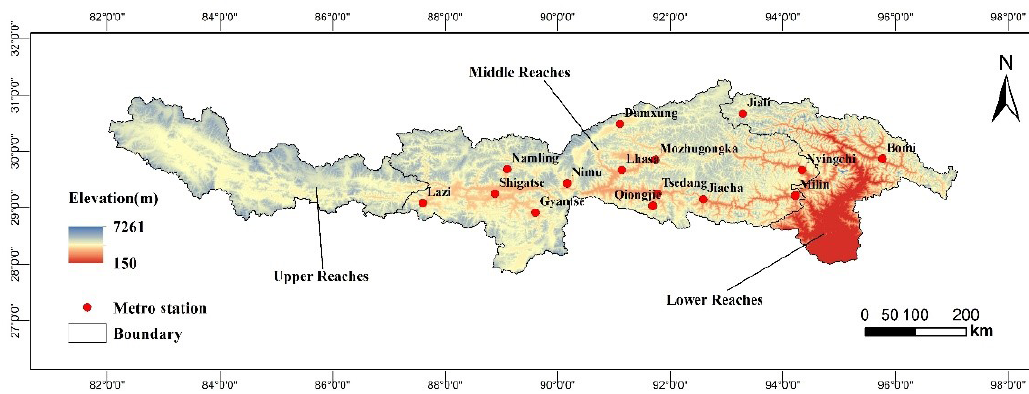
Figure 1. Overview of the study area and meteorological stations.